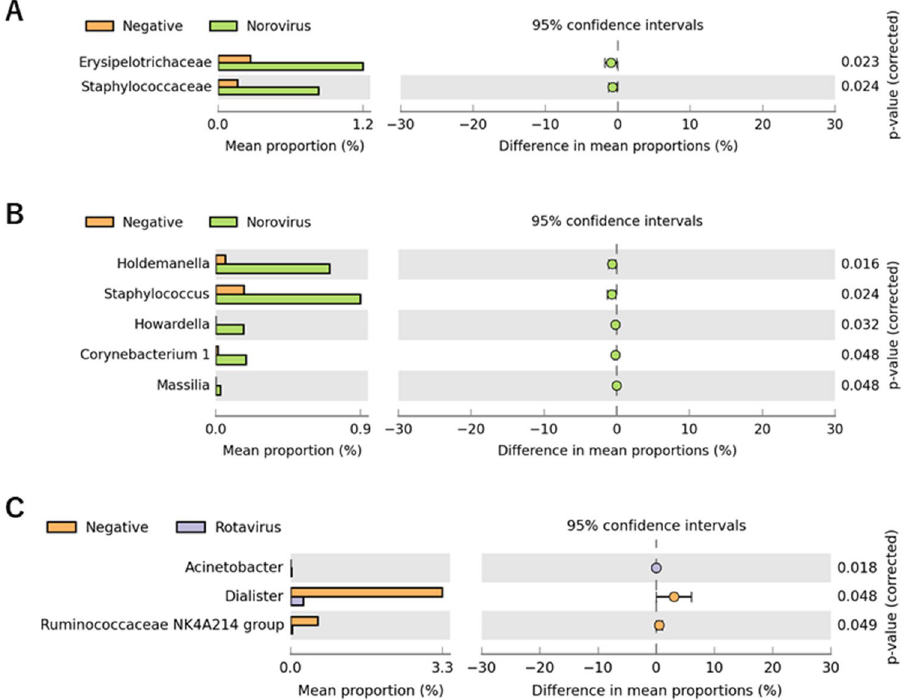
Figure 5. Comparing fecal bacteria abundance between enterovirus positive and negative diarrhea patients. Comparison of gut microbiota between enterovirus positive or negative diarrhea patients by STAMP analysis. ( A ) The difference of gut microbiota between norovirus detected and non-viral detected diarrhea patients at the family level ( A ) and genus level ( B ). The difference of gut microbiota between rotavirus positive and non-viral detected diarrhea patients at the genus level ( C